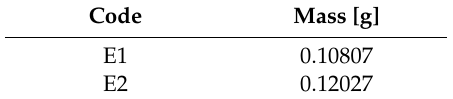
Table 12. Inductively coupled plasma-mass spectrometry (ICP-MS) analysis results and conversion to units [mg / kg] and [%]. 0.01% = 100 mg / kg. DL: detection limit.